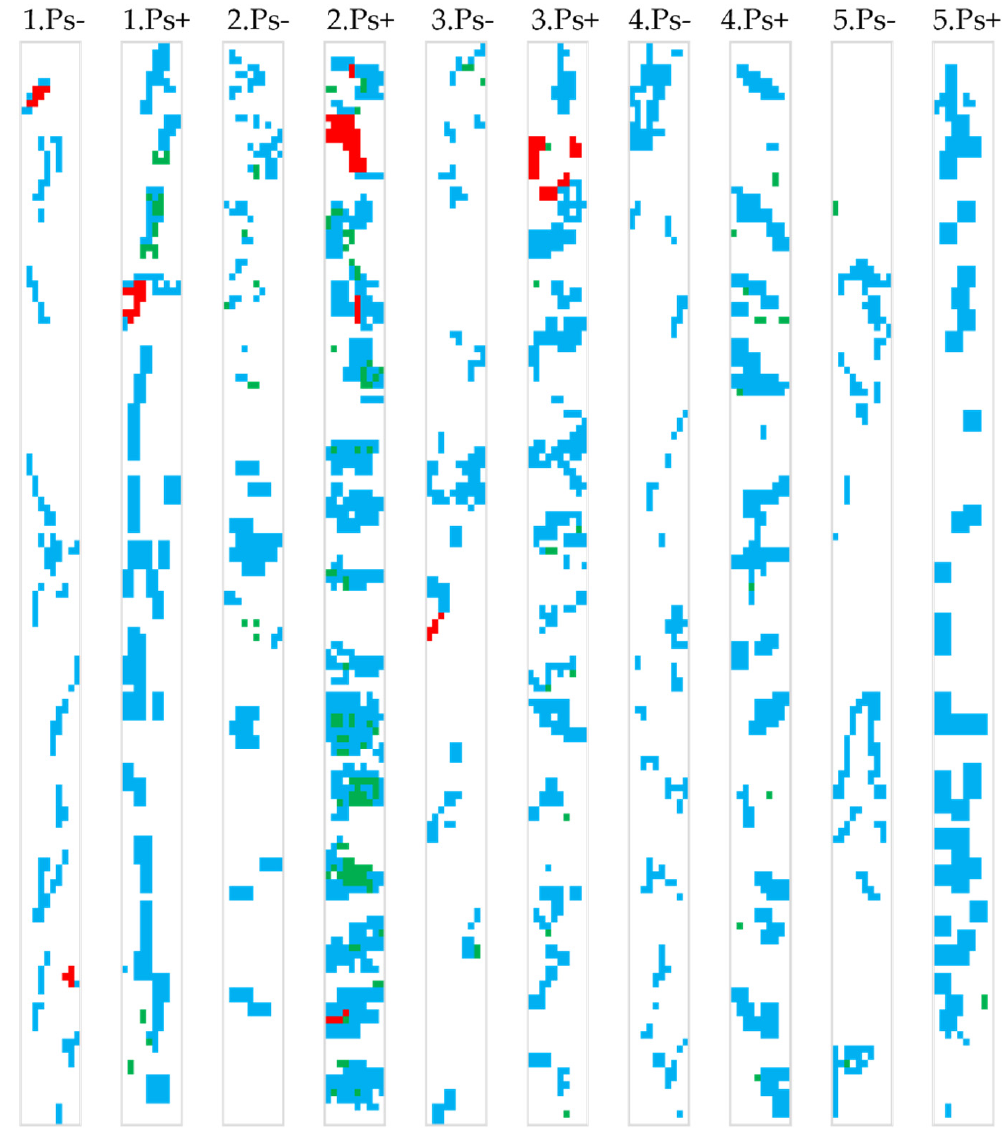
Figure 6. Proliferative (Ps) colonization strategy. Legend: 1 ‐ V1 (control variant)—untreated; 2 ‐ V2— organic (manure) treatment—10 t ha − 1 manure; 3 ‐ V3—low ‐ mineral organic treatment—10 t ha − 1 manure + 50 N 25 P 2 O 5 25 K 2 O; 4 ‐ V4—mineral treatment—100 N 50 P 2 O 5 50 K 2 O; 5 ‐ V5—high ‐ mineral organic treatment—10 t ha − 1 manure + 100 N 50 P 2 O 5 50 K 2 O. Color Legend: blue—hyphae; red— arbuscules; green—vesicles. Minus( − ) sign—lower model of strategy; Plus(+) sign—upper model of strategy. Square color in mycorrhizal maps: hyphae—blue, arbuscules—red, vesicles—green (based on original color code [50]).